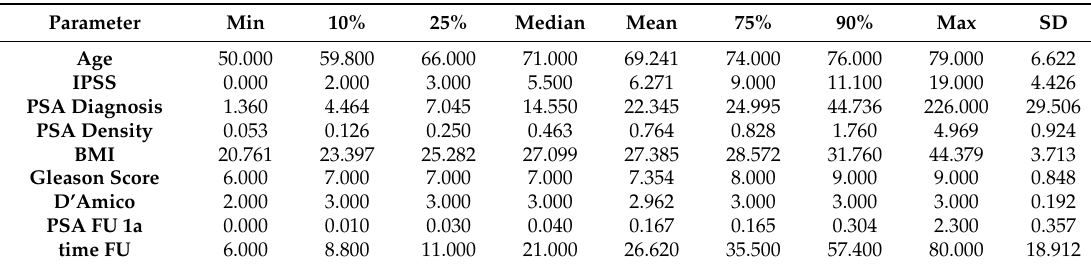
Table 1. Main clinical parameters. BMI: body mass index; FU: follow-up; IPSS: international prostate symptom score; PSA: prostate-specific